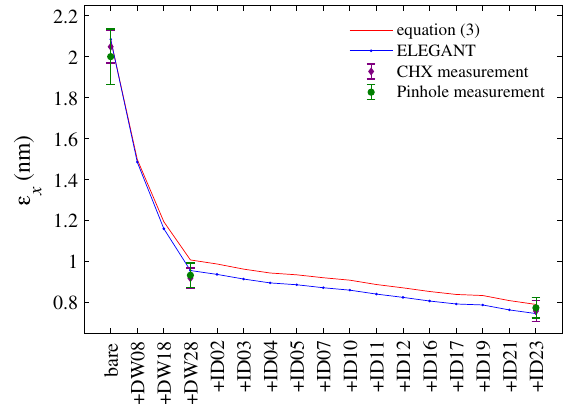
FIG. 4. Horizontal emittance vs ID